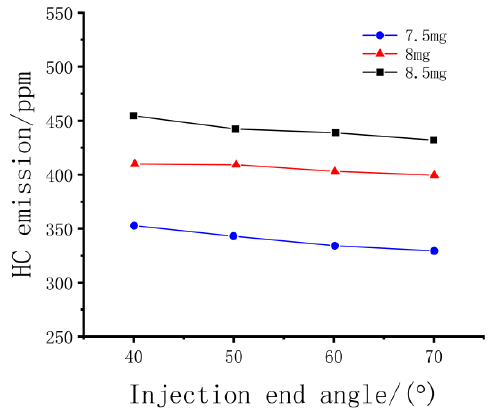
Figure 34. Effect of the injection parameters on HC emissions.